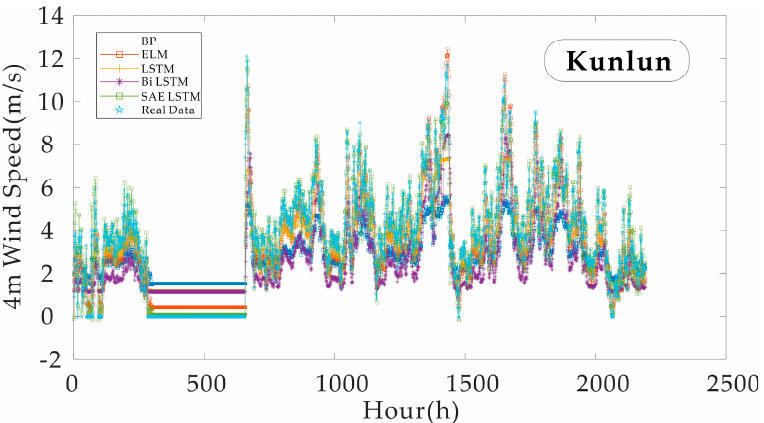
Figure 15. A comparison of the models’ predictions in the Kunlun Station 4 m wind speed data throughout the year as input data test set.